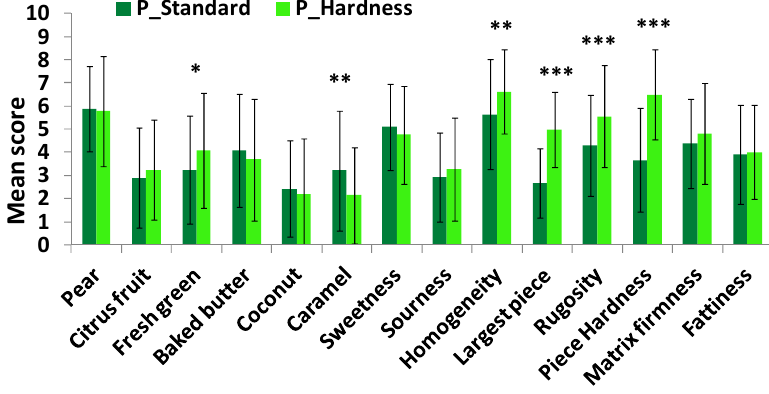
Figure 4. Sensory profiles (mean value across subjects and replicates and standard deviations) of P_Standard and P_Hardness yogurts for each sensory attribute (level of difference